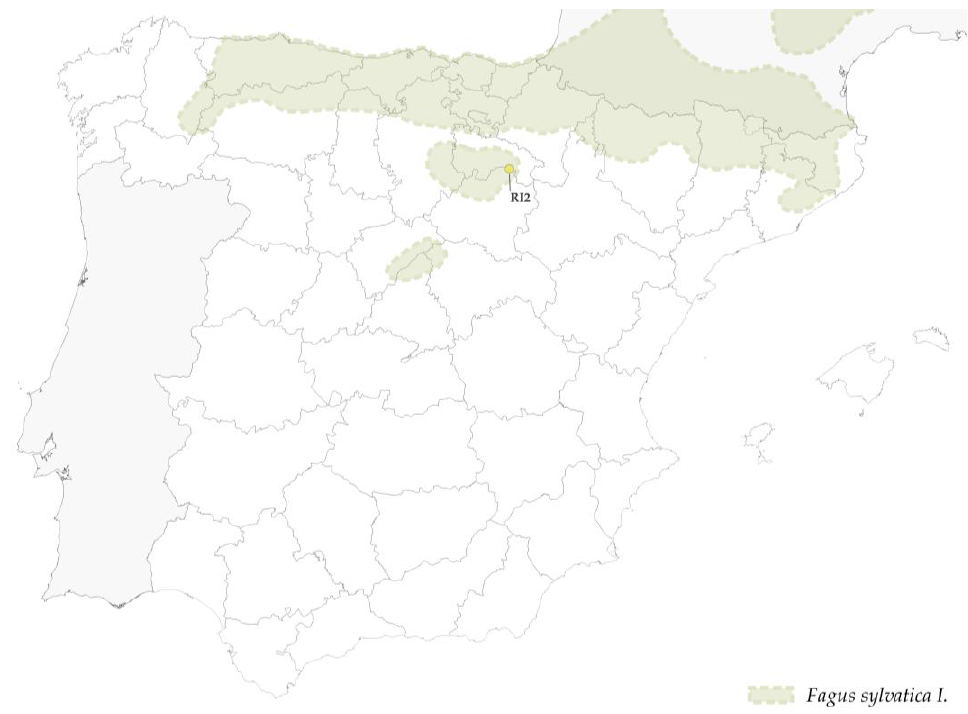
Figure 14. Characteristic sections of sample RI2 identified as belonging to the Fagus genus: ( a ) Cross- section; ( b ) Tangential section; ( c ) Radial section.